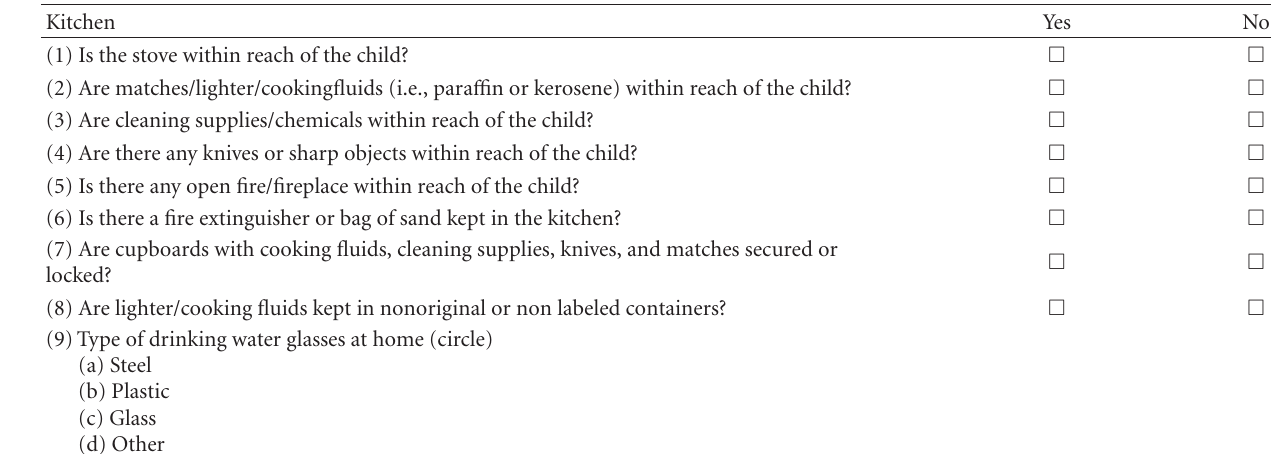
Table 2: Example from home hazard assessment tool: kitchen area.